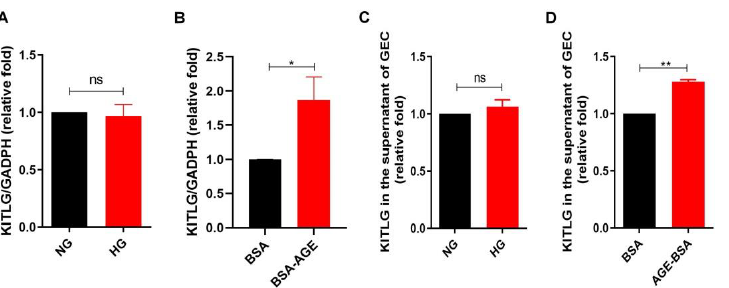
Figure 2. AGEs increased KITLG expression in GECs. ( A ) KITLG mRNA expression in HGECs treated with NG (5.5 mM) or HG (25 mM) for 24 h ( n = 3). ( B ) KITLG mRNA expression in HGECs treated with BSA (300 μg/ml) or AGE–BSA (300 μg/ml) for 24 h ( n = 3). KITLG mRNA levels were assessed by quantitative real-time polymerase chain reaction (qRT-PCR). ( C , D ) KITLG protein level in the supernatant of HGECs treated with NG, HG, BSA, and AGE – BSA for 48 h. The level of KITLG was determined by an ELISA kit. The bar graph represents the mean ± S.E.M. ns = not significant, * p < 0.05, ** p < 0.01 by Student’s t test.